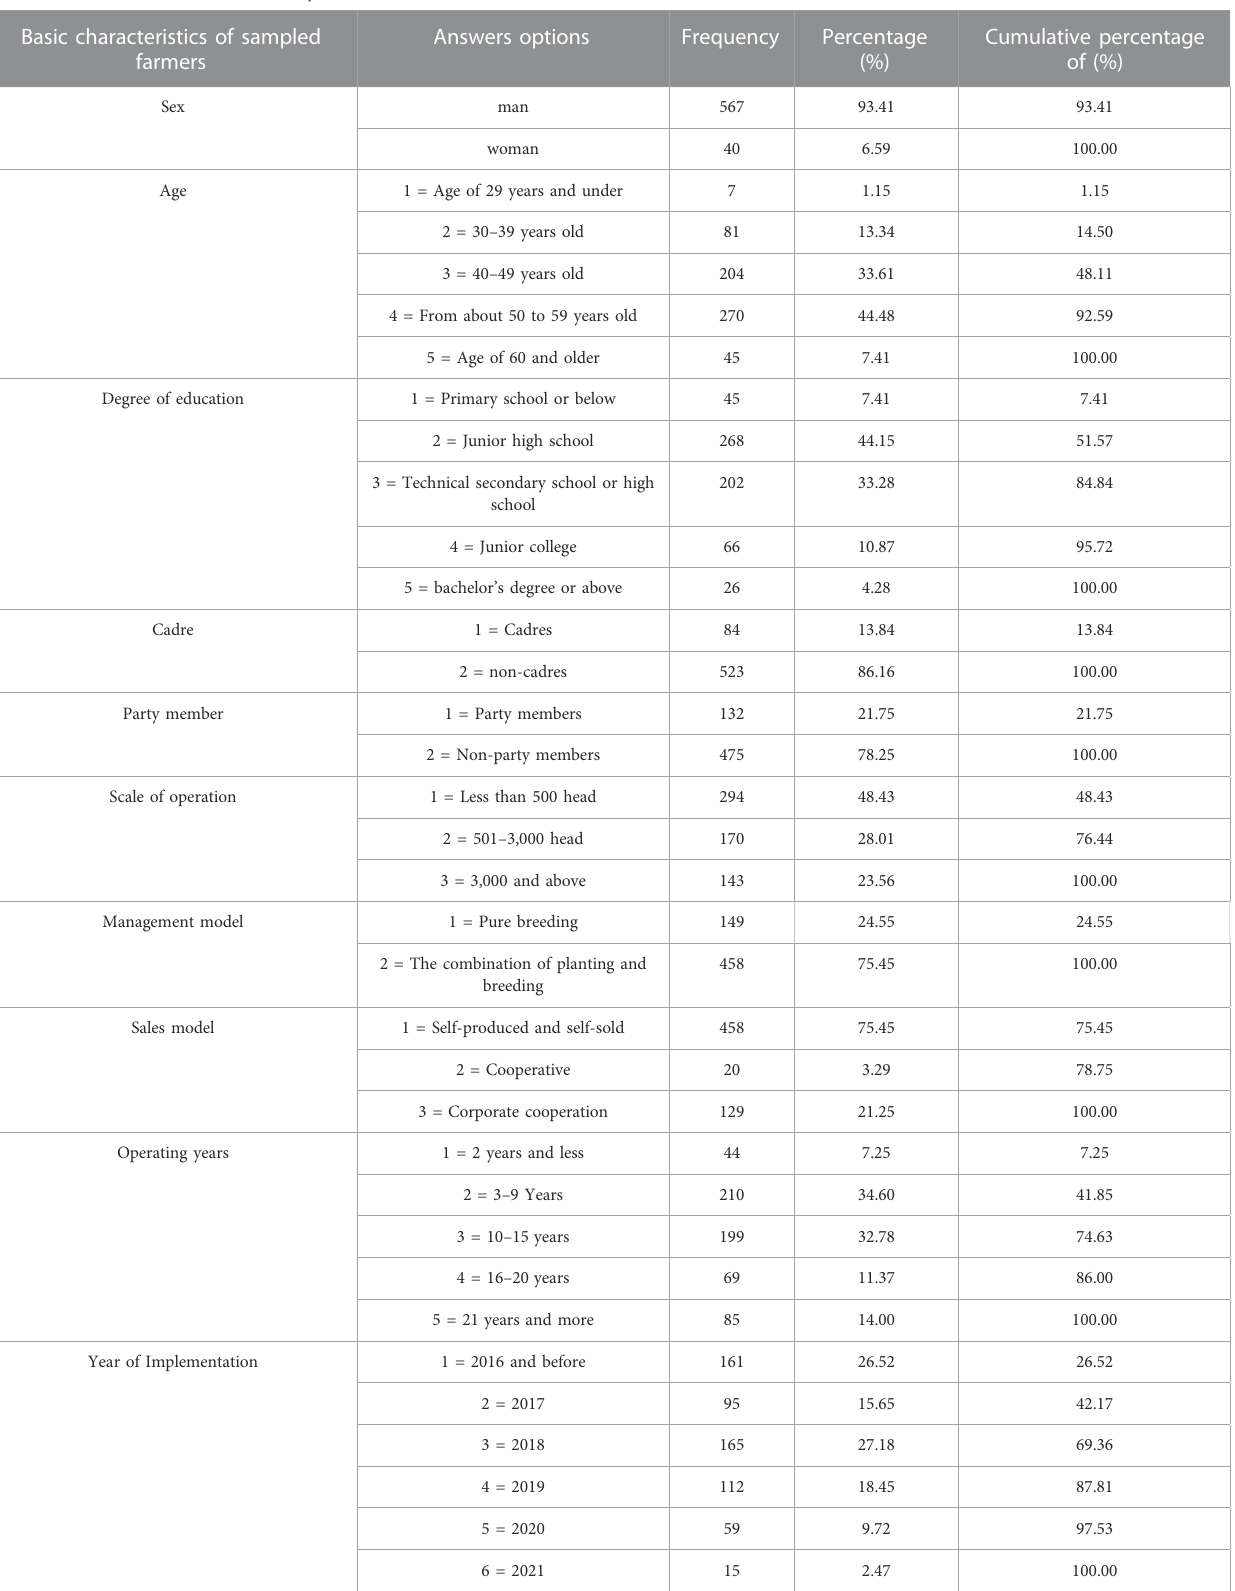
TABLE 1 Basic characteristics of the sample farmers. Basic characteristics of sampled